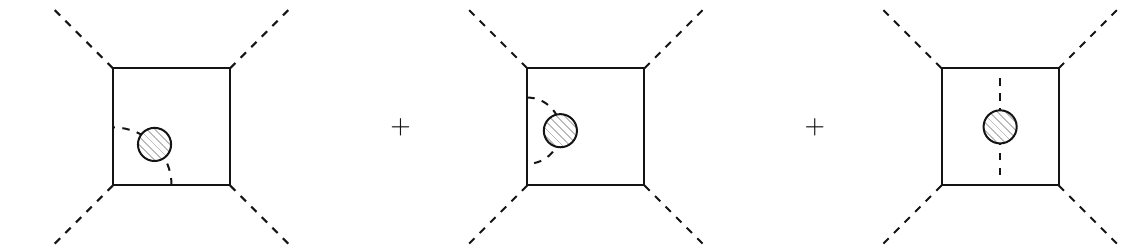
Fig. 5 Different types of box diagrams for F 2 ( yN ) . The gray blob represents a chain of fermion bubbles